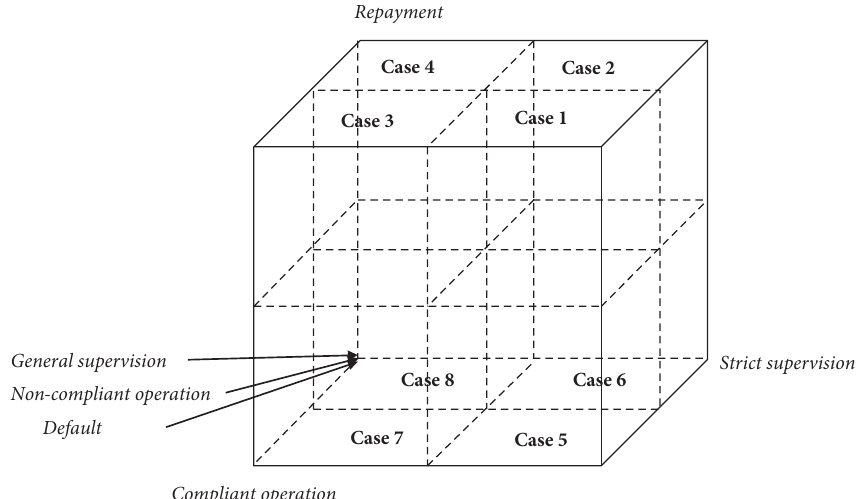
Figure 2: The EGM among regulatory authorities, P2P lending platforms, and borrowers. Table 2: Return matrix of the three players: regulatory authorities, P2P lending platforms, and borrowers. Regulatory